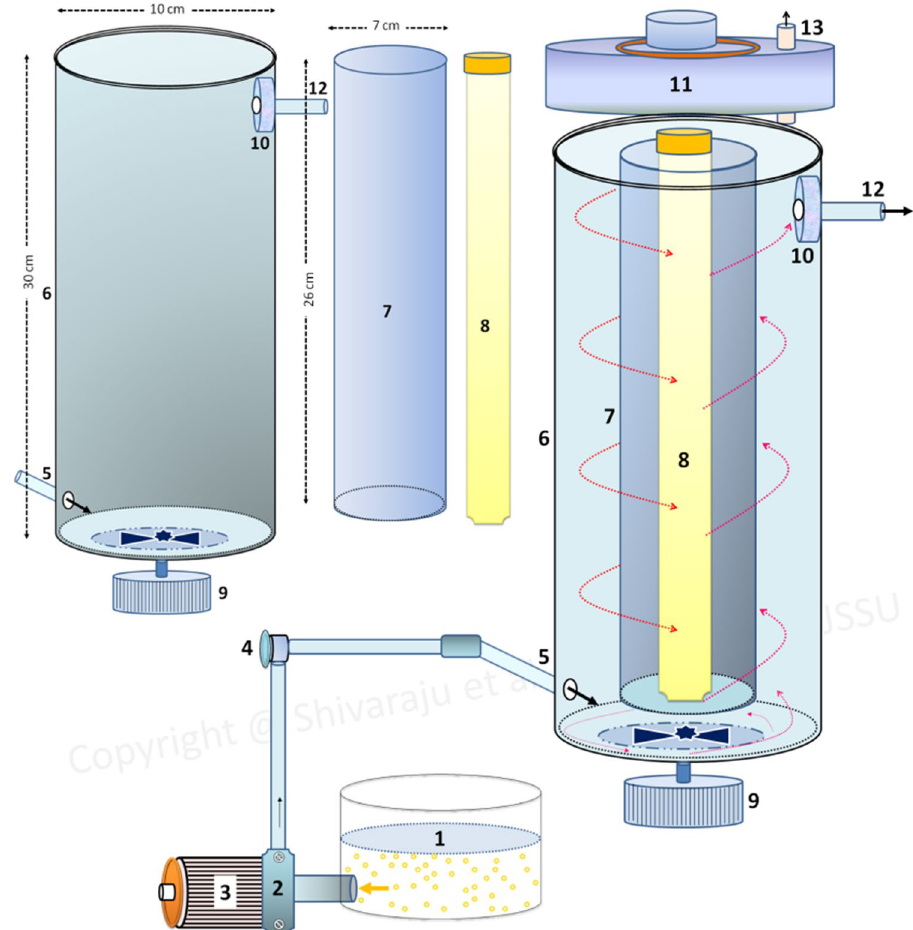
Fig. 11 Continuous photoreac- tor vertical model: (1) aqueous solution of chlorobenzene (50 µg/L) with Fe–Mn–CeO 2 / TiO 2 composite nanoparti- cles; (2) water pump with 50 L/h; (3) motor 320 V; (4) flow controlling valve with glass pipe set (2 cm diameter); (5) inlet of photoreactor; (6) borosil outer shield (10 cm W x 30 cm L); (7) quartz inner cover (7 cm W × 26 cm L); (8) light source (LED bulb, 16 W); (9) stirrer with machine; (10) nanomembrane filter; (11) upper lid with light intensity controller and electric connections; (12) outlet of photoreactor; (13) gas outlet of